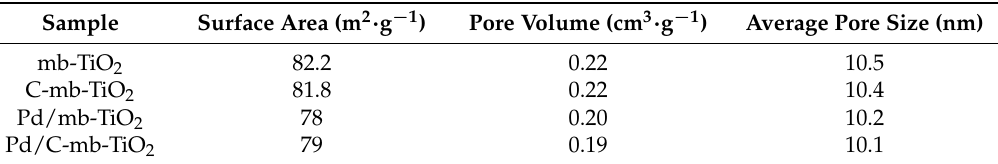
Figure 2. N 2 adsorption-desorption isotherms and the pore-size distribution of the samples. Table 1. Structural properties of the supports and catalysts.